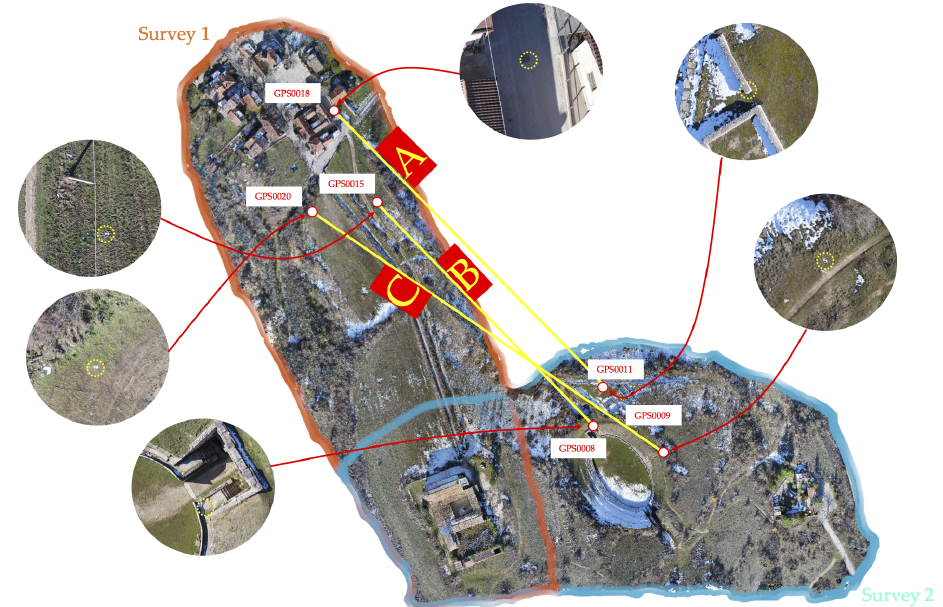
Figure 10. Measured distances (in yellow) between GCPs for the evaluation of the realignment